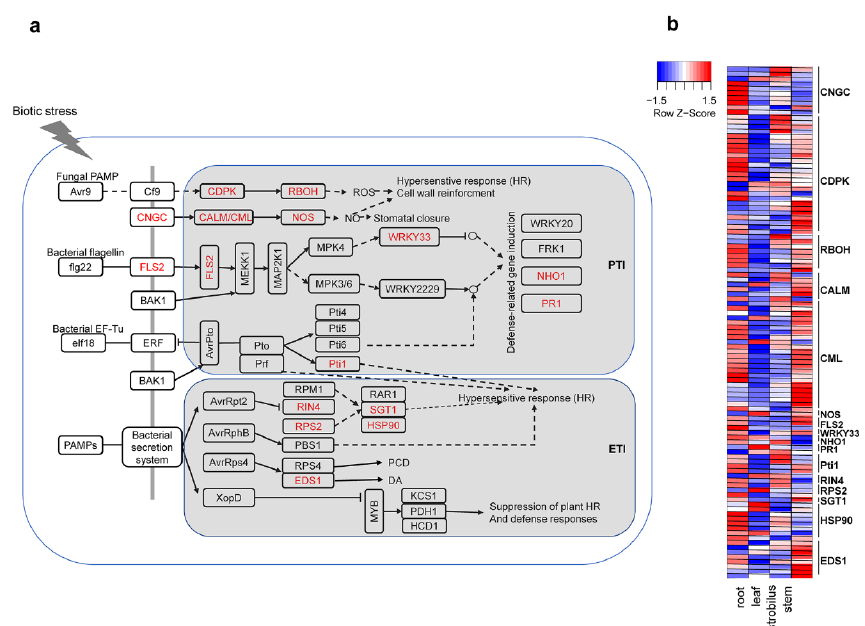
Figure 10. Plant–pathogen interactions in P. chienii and the differentially expressed genes